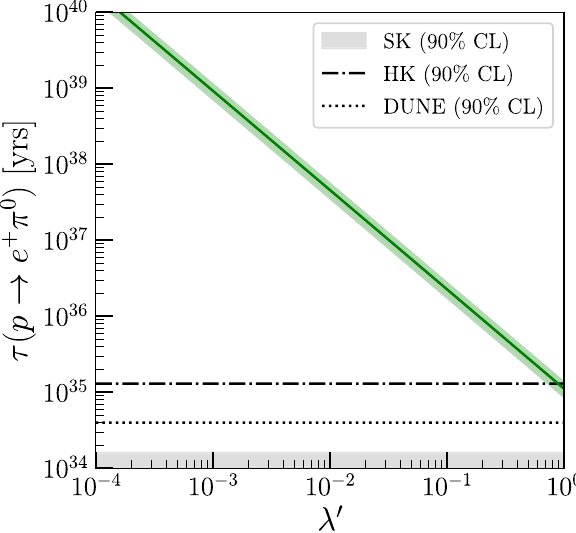
Fig. 17 Dimension-sixprotondecaylifetime τ( p → e + π 0 ) asafunc- tion of λ (cid:7) for m 1 / 2 = 9 . 8 TeV, m 0 = 14 . 1 TeV, tan β = 5, A 0 / m 0 = 3, μ > 0, with the green band showing the uncertainty. The horizon- tal dash-dotted and dotted lines show the 20-year 90 % CL sensitivity of Hyper-K and DUNE, respectively, while the gray shaded area is excluded by Super-Kamiokande